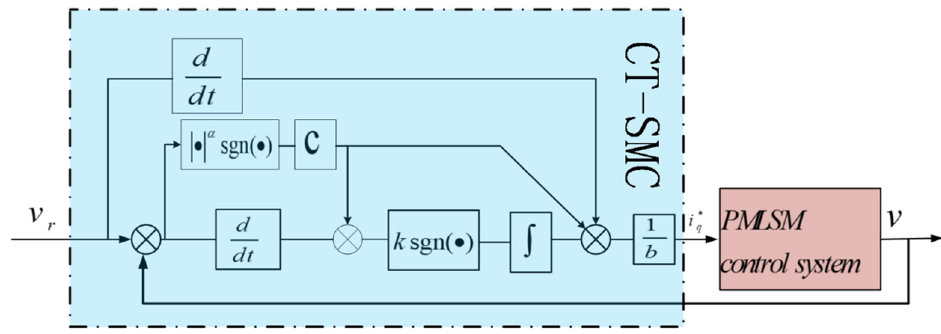
Figure 1. System block diagram of PMLSM based on CT-SMC.